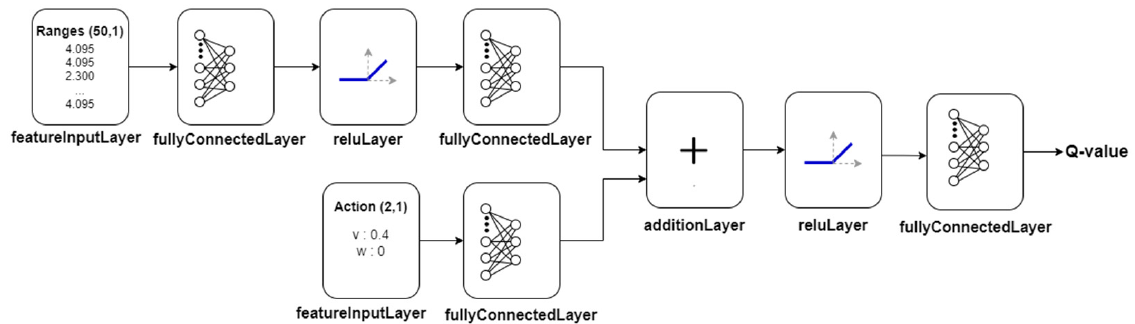
Figure 6. Critic network with 50-D input of observation path and 2-D input of action path. The network ends with the single-neuron output of the Q-value.